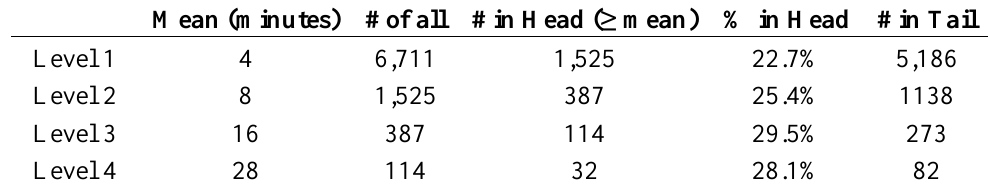
Table 1. The numbers and percentages of spatio-temporal clusters in the head and tail on